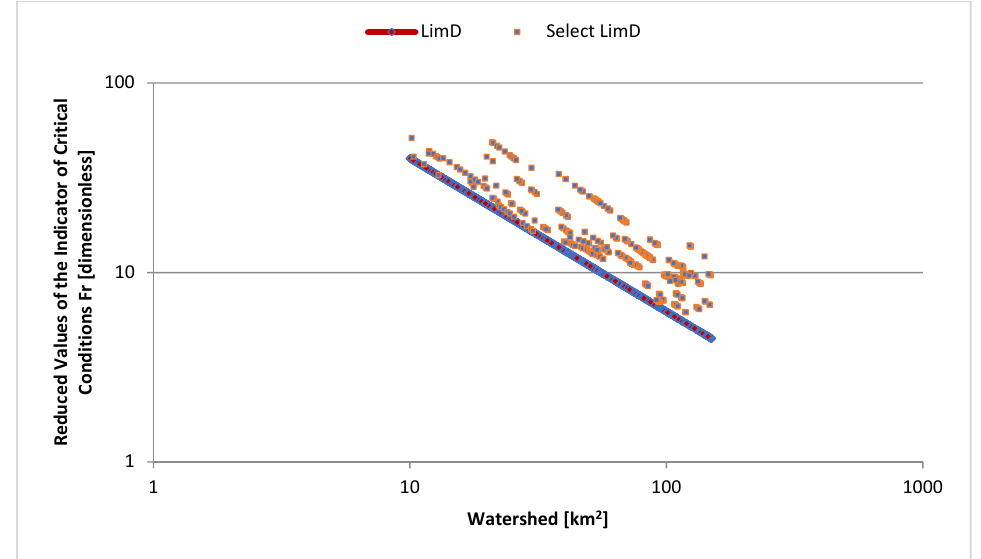
Figure 7. Selection of localities according to the testing criterion (5) within the group of watersheds 201–202–203.